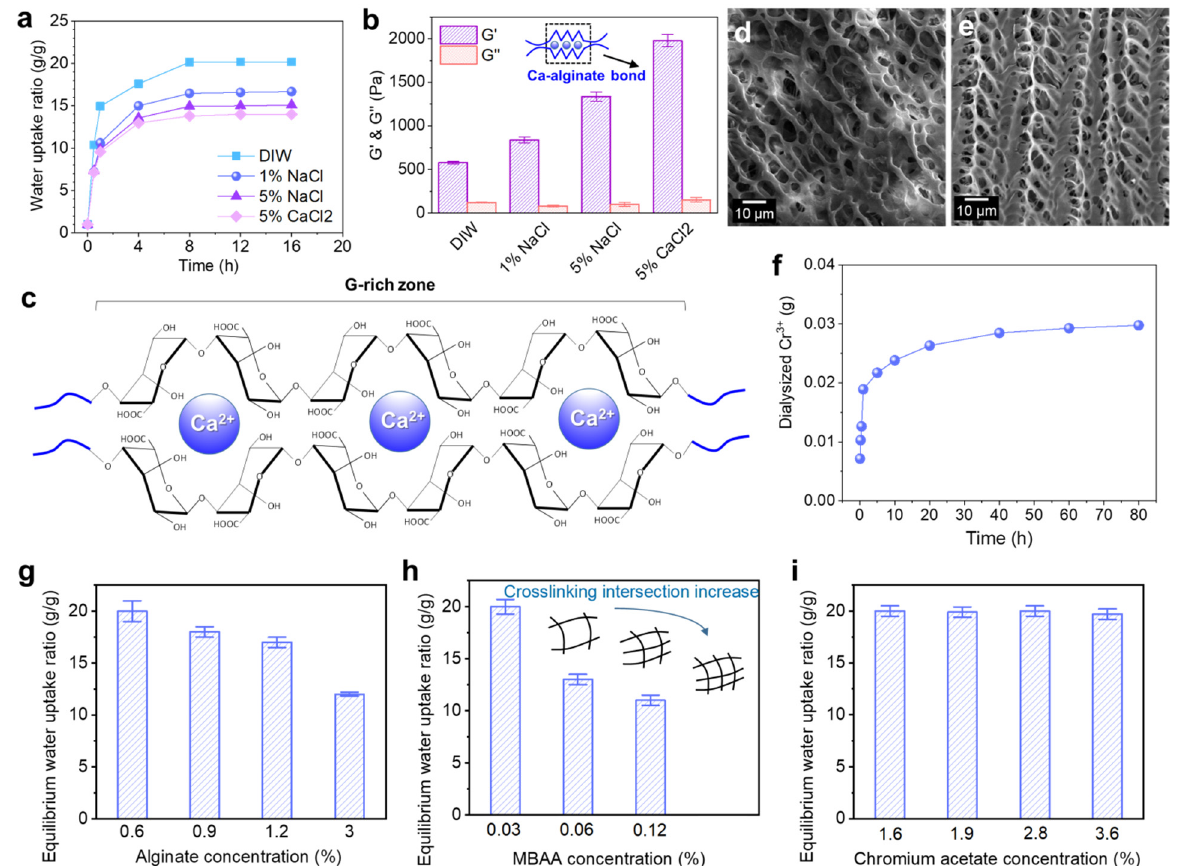
Figure 2. Water uptake and ionic exchange of the Alg-IPNG gels: ( a ) water uptake kinetic curves of the Alg-IPNG particles in different types of brines; ( b ) elastic modulus (G’) and loss modulus (G’’) of the equilibrium swollen Alg-IPNG particles; ( c ) structure of the Ca–alginate bond; ( d , e ) micro-structures of the swollen Alg-IPNG particles immersed in 5% NaCl and 5% CaCl 2 . respectively. ( f ) The amount of dialyzed Cr 3+ as a function of time; The effect of ( g ) alginate, ( h ) MBAA, and ( i ) chromium acetate on the swelling profile of the Alg-IPNG particles in 0.1% CaCl 2 .